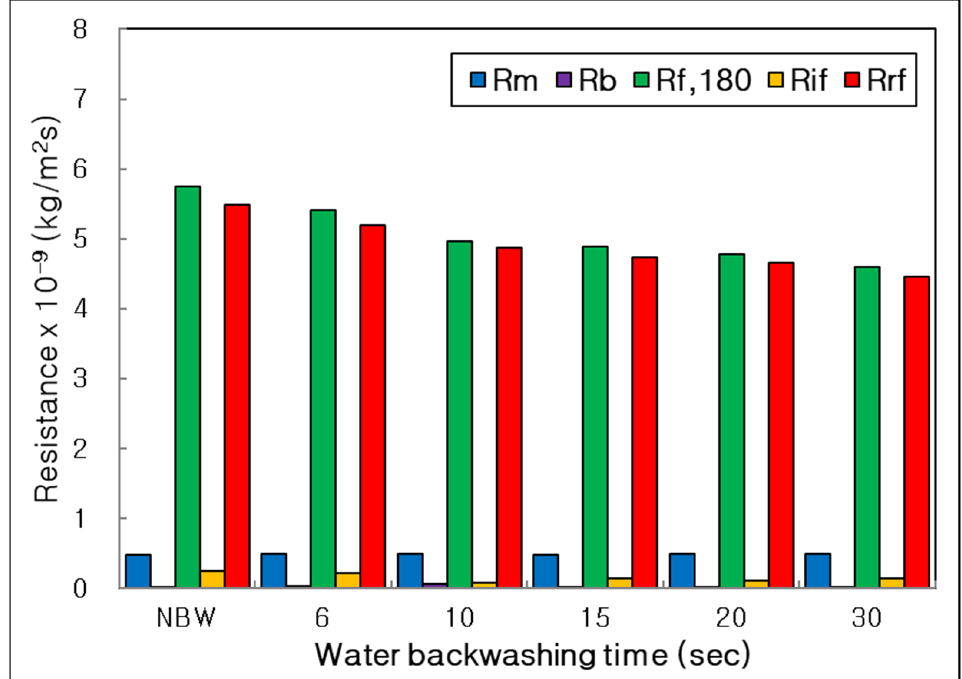
Figure 4. Influence of water backwashing time on resistances of membrane, boundary layer, final, irreversible and reversible membrane fouling (R m , R b , R f,180 , R if , R rf ) in the combined process of tubular alumina MF (NCMT-7231) and PP beads with UV irradiation and periodic water backwashing. Table 3. Water quality and treatment efficiency of turbidity in the combined process of tubular alumina MF (NCMT-7231) and PP beads for the influence of water backwashing time. Turbidity BT (s)